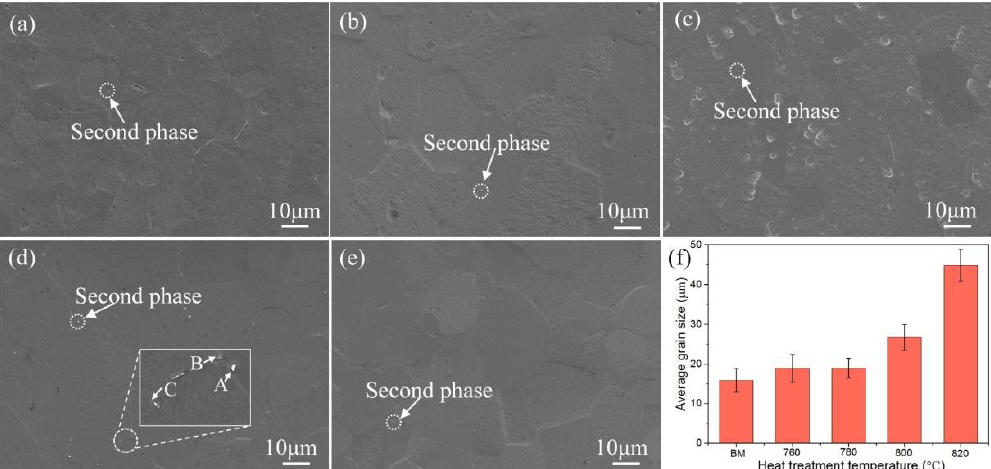
Figure 2. Microstructure of Zr-4 alloy after different thermal cycling treatment: ( a ) base material, ( b ) 760 °C/60 min, ( c ) 780 °C/60 min, ( d ) 800 °C/60 min, and ( e ) 820 °C/60 min, ( f ) the grain size of Zr-4 alloy after heat treatment at different temperatures. Table 1. Chemical composition and possible phase of each point marked in Figure 2d (at. %).